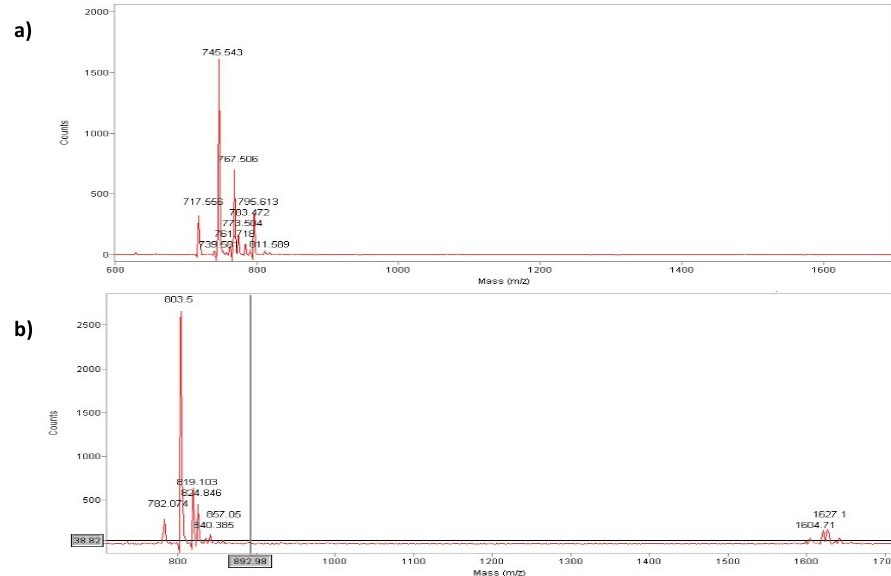
Figure 3. Maldi-Tof analysis of peptide ( a ) (MH+ = 744 a.m.u) and peptide ( b ) (MH+ = 803 a.m.u.).